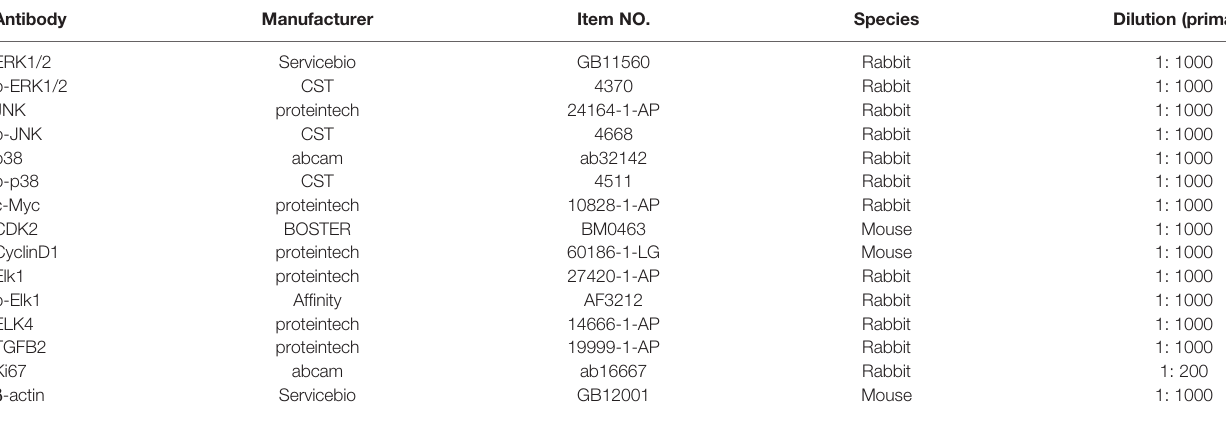
TABLE 2 | Information of antibodies for Western blot, immuno fl uorescence staining, and IHC.